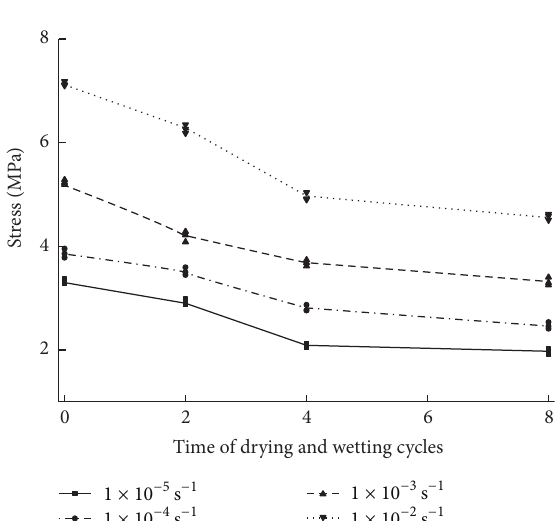
Figure 3: Stress-strain full curves of CA mortar.